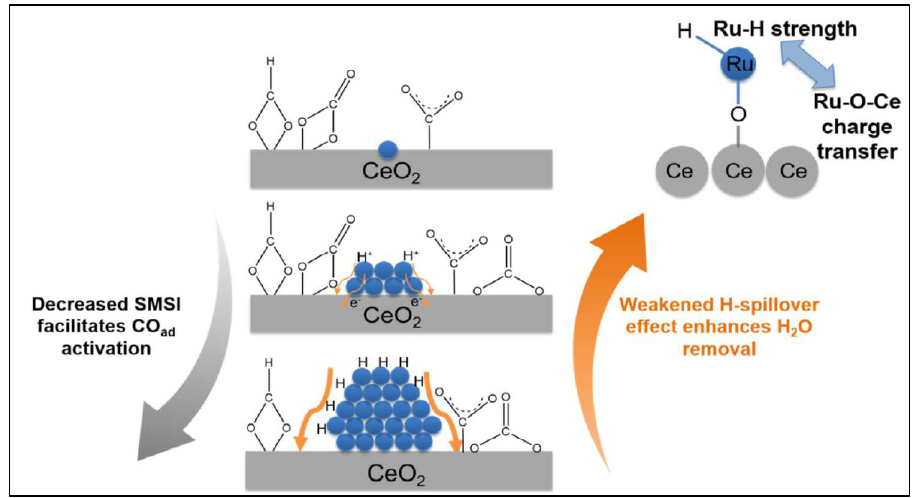
Figure 27. Schematic depiction of the competitive effects of SMSI and hydrogen spillover leading to competing activation and surface CO dehydration for CeO 2 -supported Ru single atoms (up), nanoclusters (middle) and large nanoparticles (bottom). Reproduced with permission from Ref. [240]. Copyright© 2018, American Chemical Society.